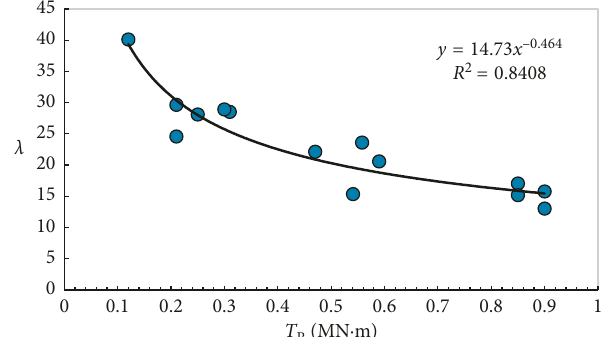
Figure 4: Relationship between λ and torque.